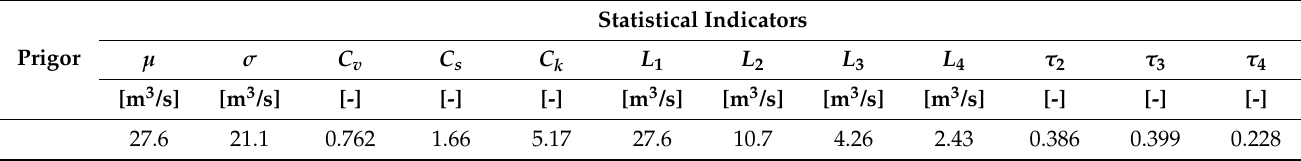
Table 4. The statistical indicators of the data